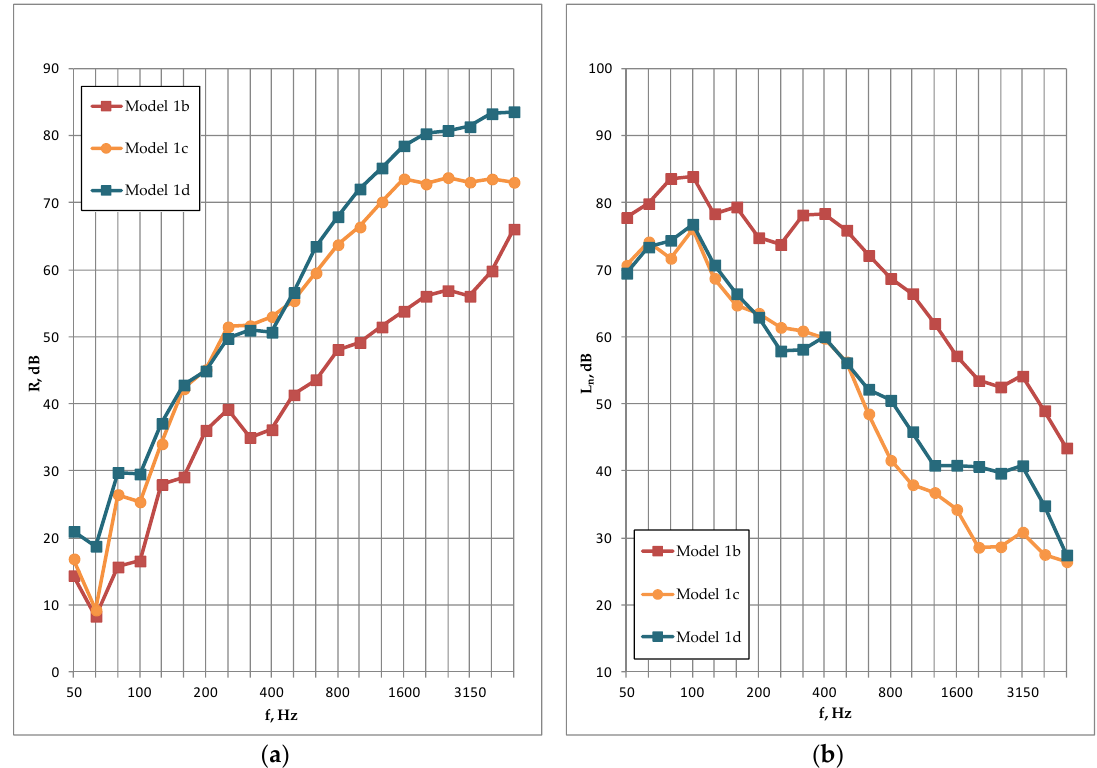
Figure 8. Airborne ( a ) and impact ( b ) sound insulation test results of models 1c and 1d of the wooden floor compared to the basic construction (model 1b).